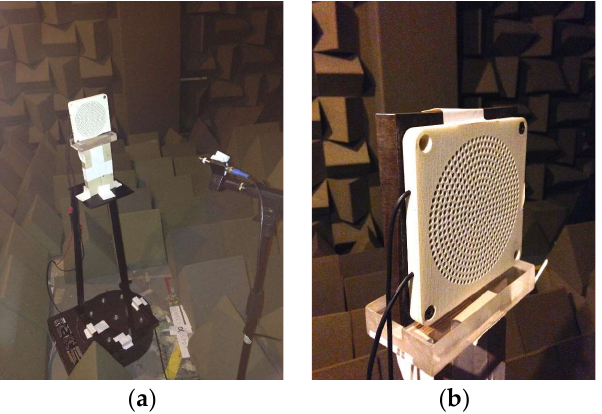
Figure 10. Experiment to measure directivity in a semi-anechoic: ( a ) DEAP loudspeaker mounted on a turntable; and ( b ) DEAP loudspeaker with a steel backing.